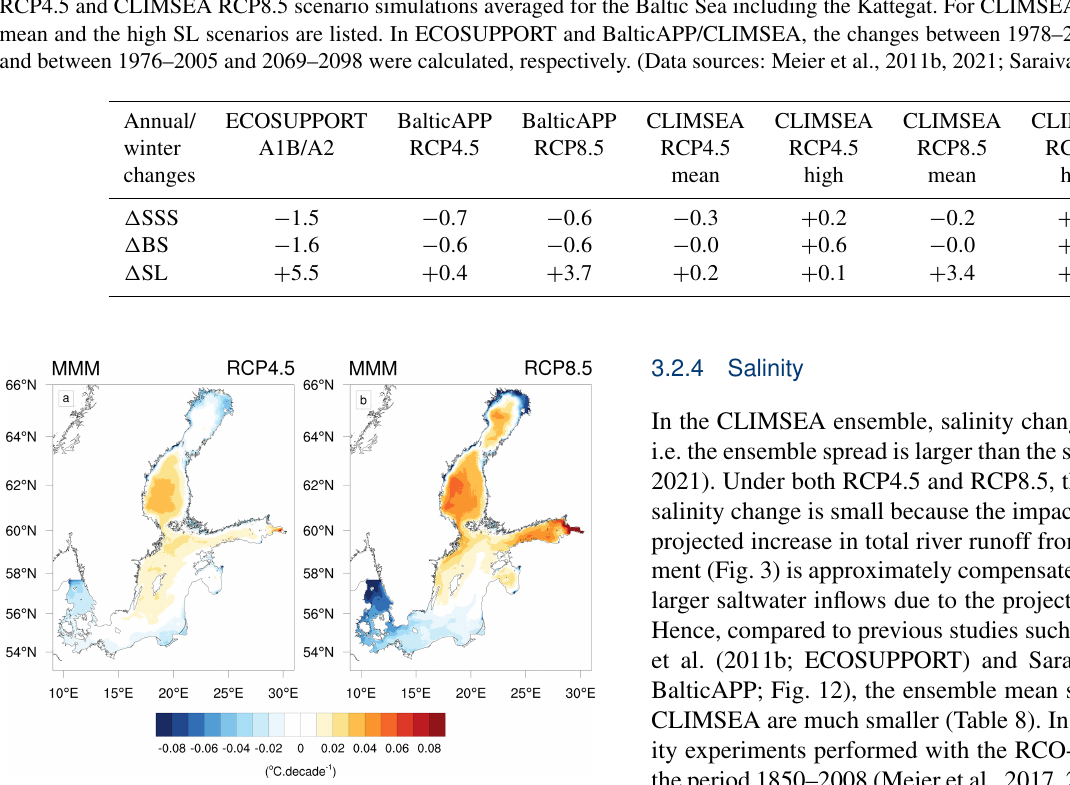
Figure 14. MMM of the annual SST trends relative to the spatial average (in ◦ C per decade) for the (a) RCP4.5 and (b) RCP8.5 sce- nario simulations. (Data source: Saraiva et al., 2019a.)